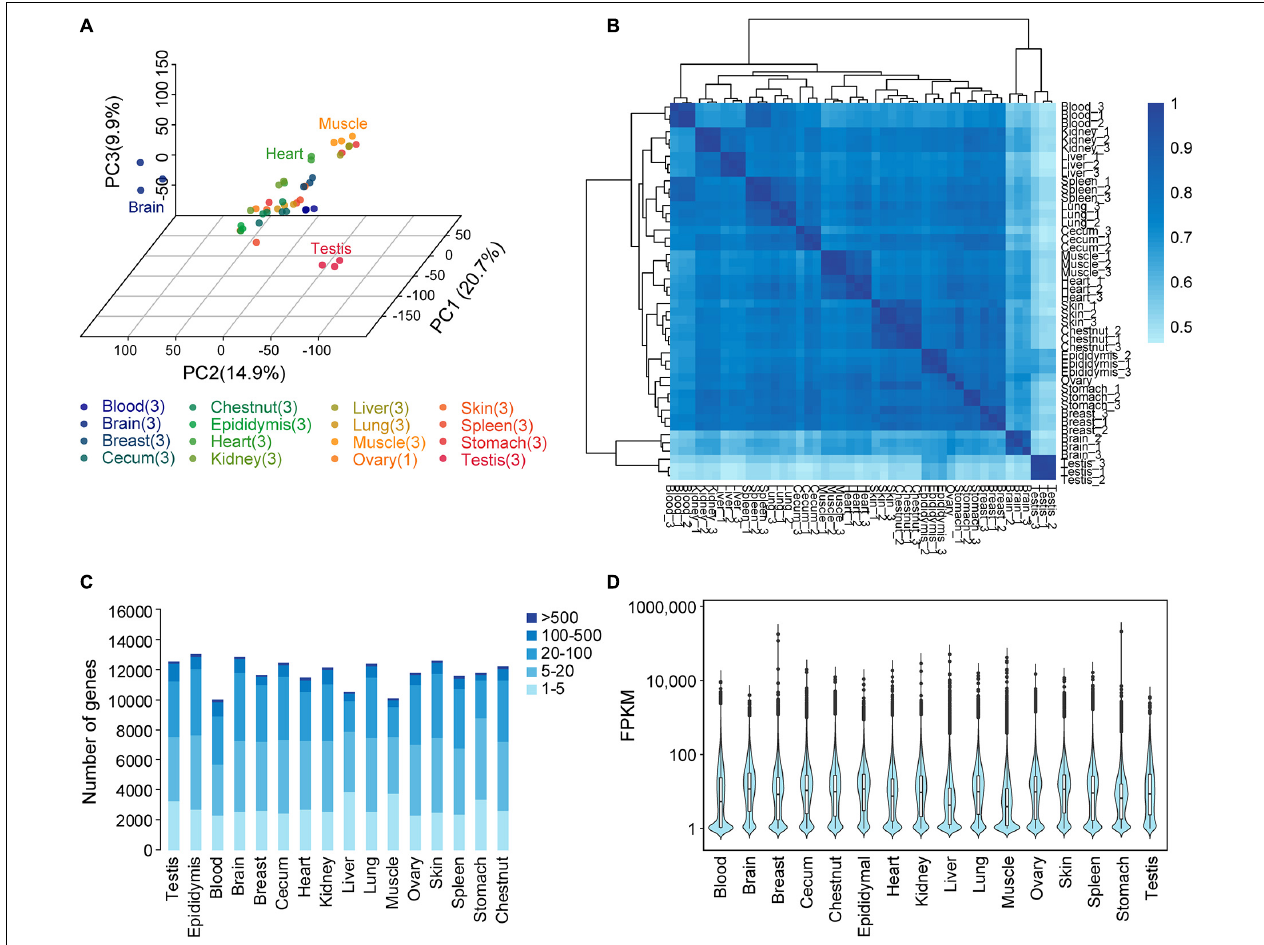
FIGURE 1 | Donkey tissues and organs analyzed by transcriptome analysis. (A) Principal component analysis and sample location. The numbers in parentheses show the number of replicate samples for each tissue. Transcripts per million (TPM) was used as a measure of gene expression. (B) Relationship between tissues. Hierarchical clustering results showing the relationships between the 16 different tissues and organs and a heat map showing the pairwise Spearman correlation. TPM was used as a measure of gene expression. (C) Total number of genes with detected transcripts in each tissue using five different abundance levels for fragments per kilobase million (FPKM) values. (D) Transcript levels (FPKM) on a log10 scale for all genes for the 16